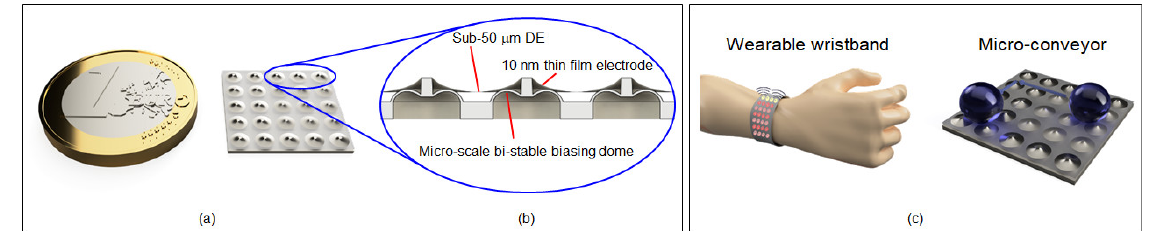
Figure 9. Future fluidics-free and highly flexible cooperative DEA-MEMS system ( a , b ), potential applications in smart textiles or self-organizing microconveyor systems ( c ).